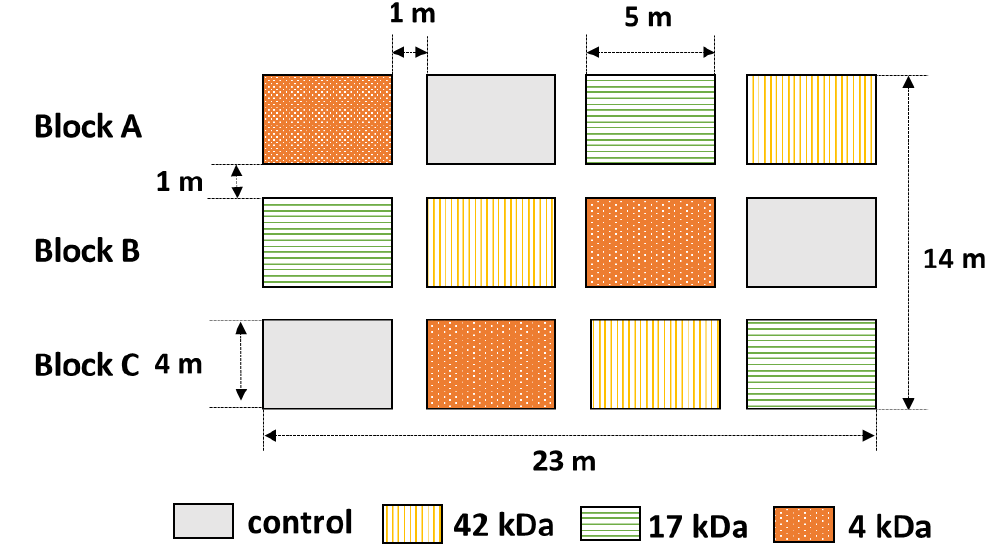
Figure 8. Field experiment design for biostimulator treatment of hybrid maize .